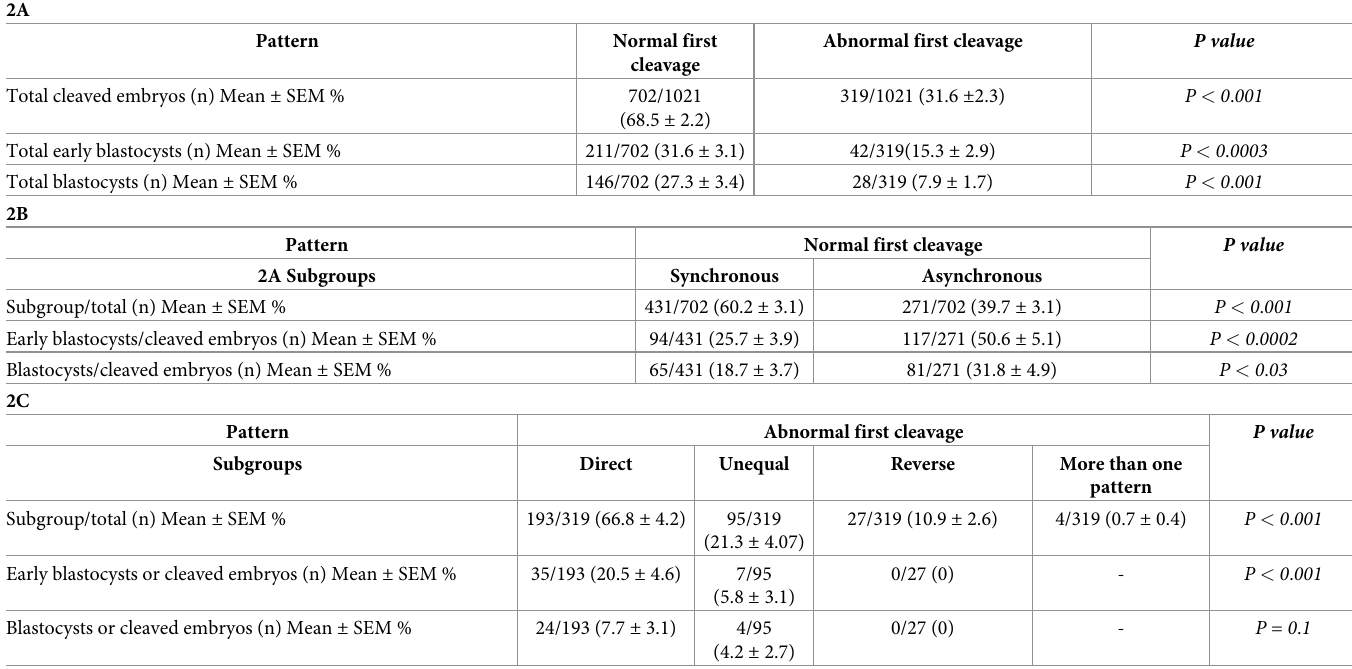
Table 2. Embryonic development and blastocyst formation in normally and abnormally cleaving groups (2A) and subgroups (2B and